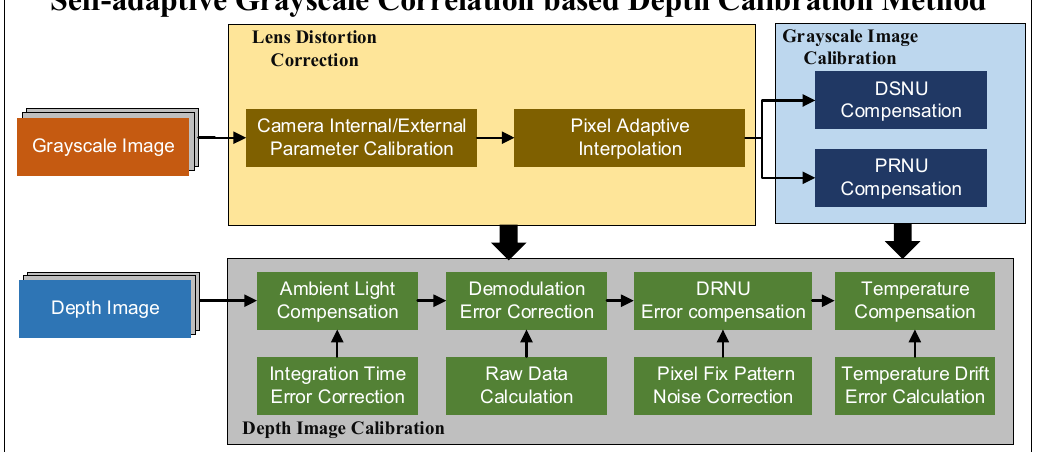
Figure 6. The comprehensive calibration model process.